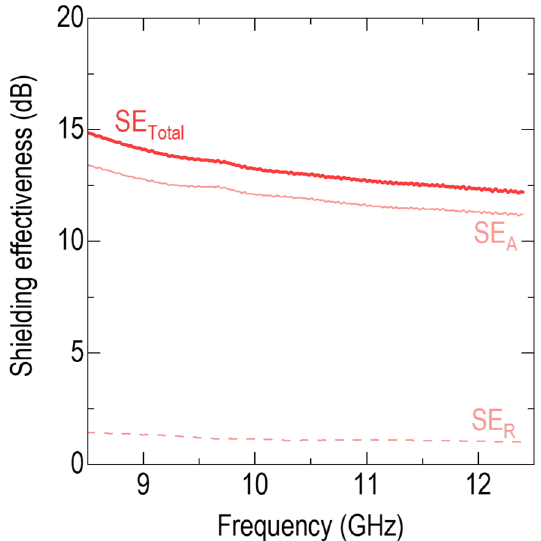
Fig. 5 Total electromagnetic shielding effectiveness (SE) of BLSO BaZrO 3 / MgO ( 0001 ) Al 2 O 3 . The films have an SE of ~ 13.2 dB at 10 GHz. SE A and SE R represent the transmitted wave through the films and Al 2 O 3 substrate and the reflected wave from the BLSO film, respectively. The films have an SE A of ~ 12.1 dB, which is larger than the SE R of ~ 1.1 dB at 10 GHz